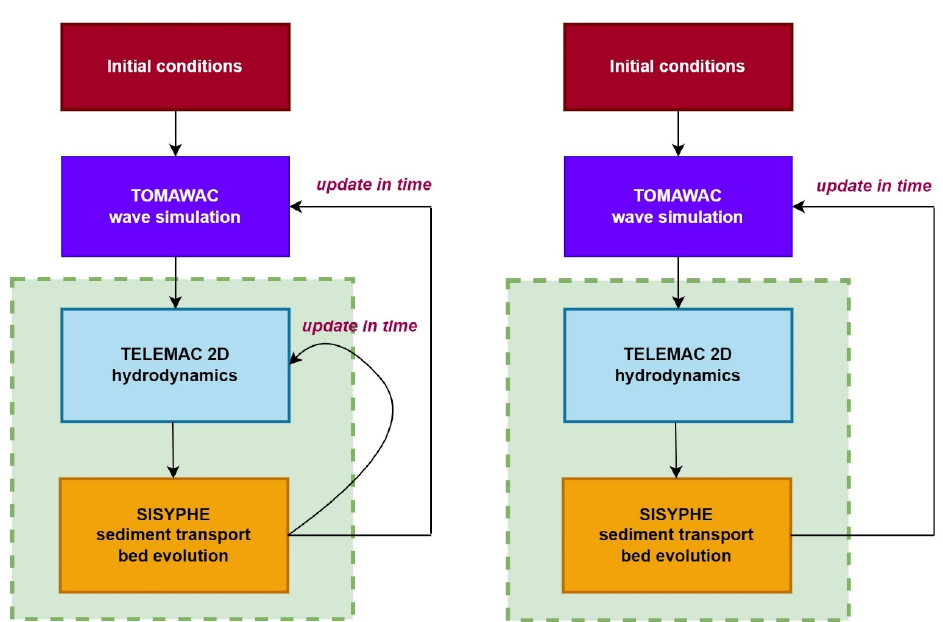
Figure 5. Schematic coupling of the three modules to simulate waves, currents, and sea bottom evolution for different coupling periods ( left ) and for identical coupling periods between the modules ( right ).